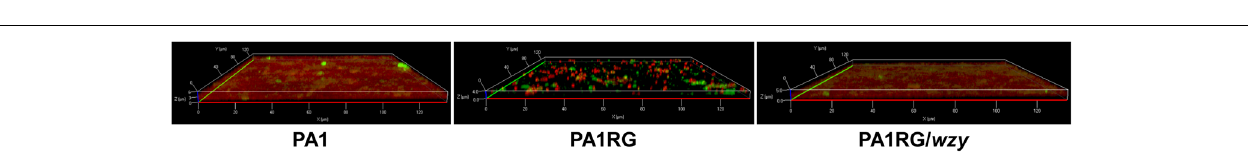
FIGURE 7 | CLSM analysis of biofilm formation. Bacterial cells in biofilm were labeled with the red fluorescent nucleic acid stain SYTO 61, and extracellular polysaccharides were labeled with the green fluorescent stain FITC-ConA. Mutant PA1RG produced thinner biofilm compared to PA1 and PA1RG/ wzy